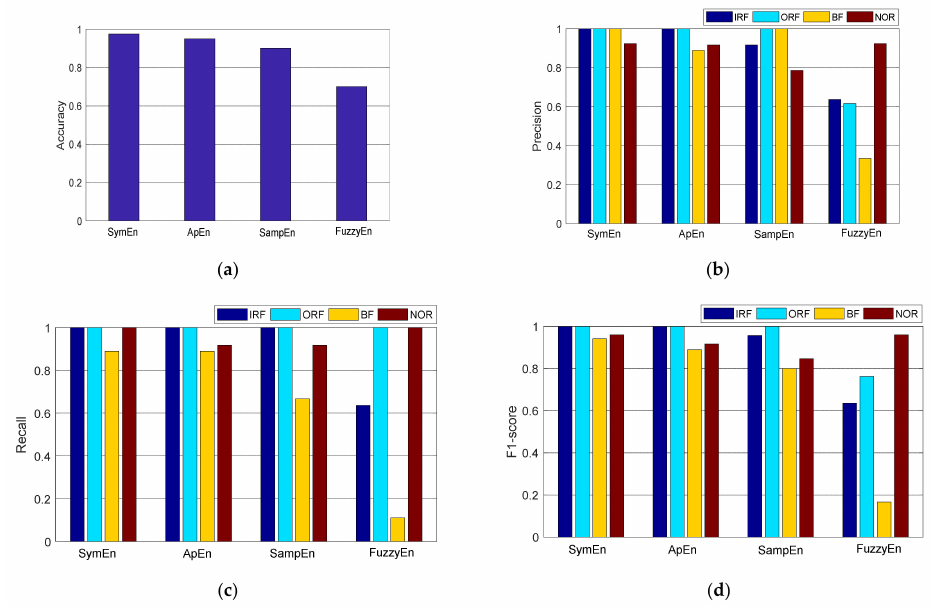
Figure 16. Evaluation criteria: ( a ) Accuracy; ( b ) Precision; ( c ) Recall; ( d ) F1-score. Table 4. Result of classification.